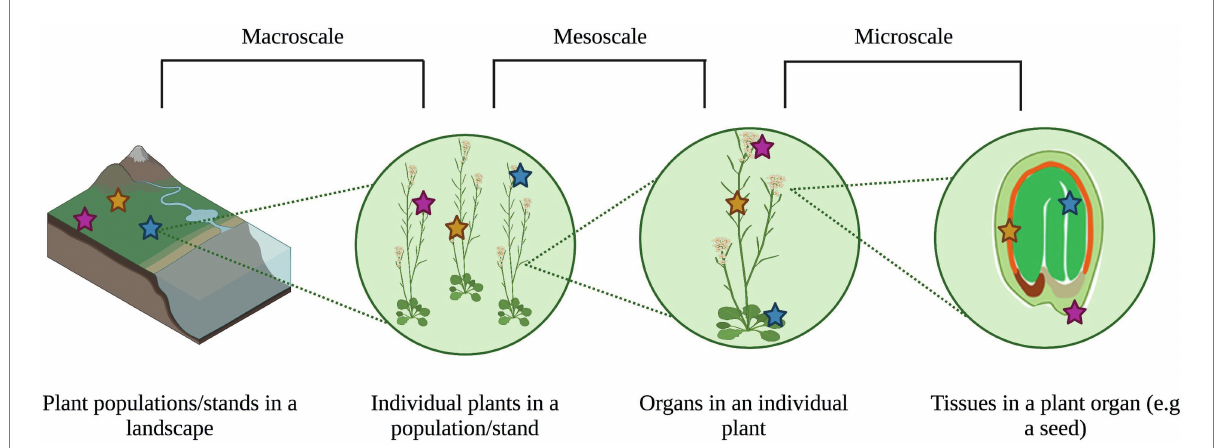
FIGURE 1 Variation in plant microbial communities can be observed at the macro-scale (i.e., meters to kilometers, or within and among sampling sites), meso-scale (i.e., centimeters to meters, or within and among plant organs to individuals), and micro-scale (i.e., nanometers to centimeters, or within and among plant organs) scales. The different colored stars represented distinct microbial communities at each scale. Image created through BioRender.com.